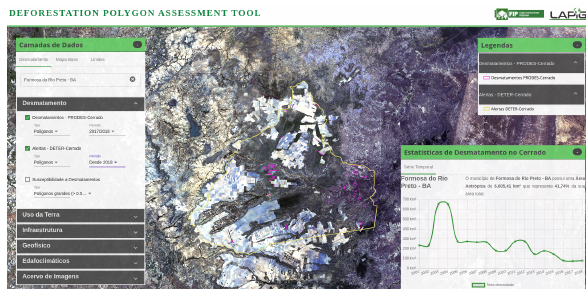
Figure 6. DPAT page presenting the PRODES-Cerrado polygons detected in 2018 properly filtered by the municipality of Formosa do Rio Preto - BA (with Sentinel image on the background).